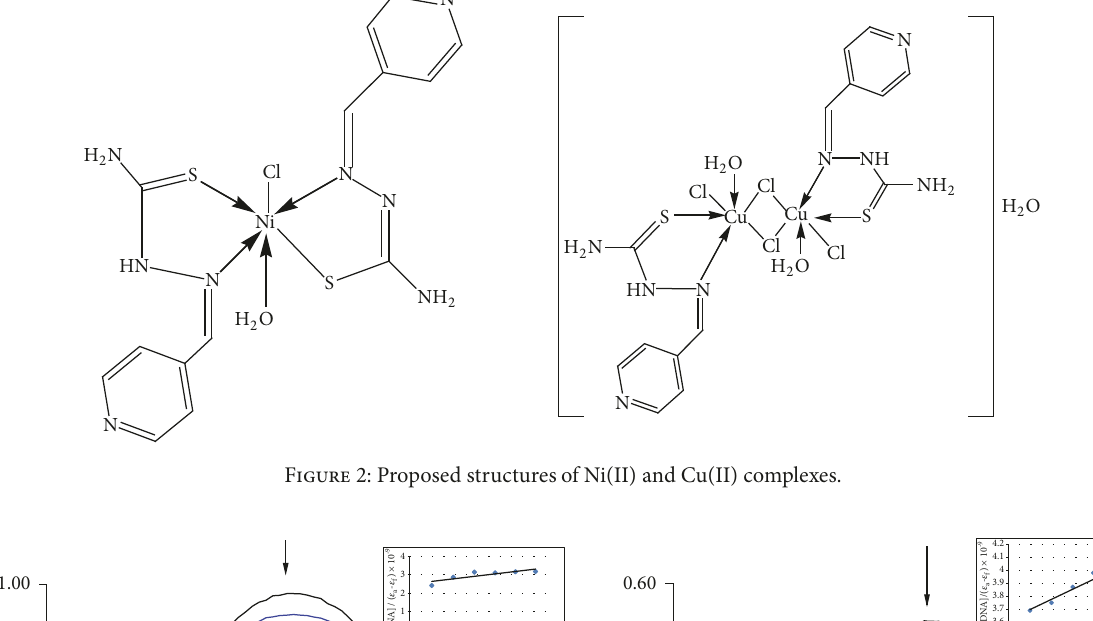
Figure 2: Proposed structures of Ni(II) and Cu(II) complexes.